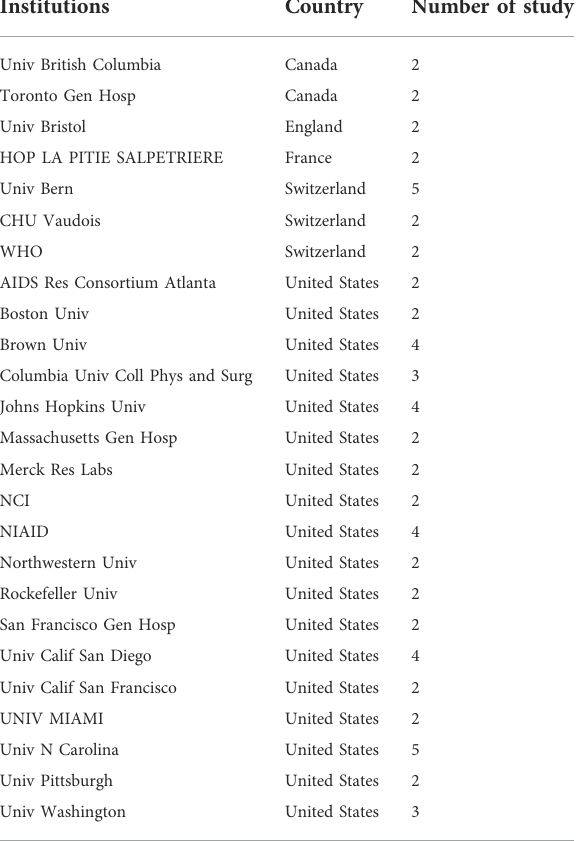
TABLE 2 Institutions for the top 100 studies in drug therapy for HIV fi